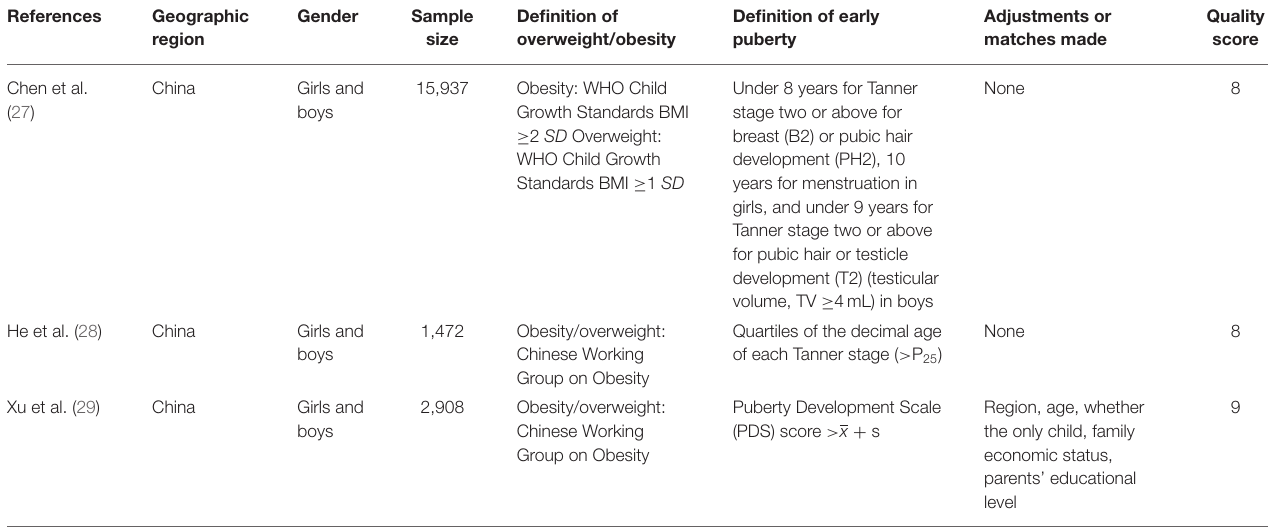
TABLE 2 | Selected characteristic of 3 case-control studies of childhood overweight/obesity and early